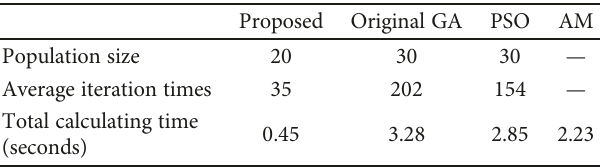
Figure 3: Comparison of calculating time using the proposed algorithm, original GA, PSO, and AM for WSF estimation. (a) p = 8 , q = 2 , and M = 100 ; all the signals are independent (noncoherent case). (b) p = 8 , q = 4 , and M = 100 ; the independent signal number is 2 (coherent case). Table 1: Comparison of computational complexity of each algorithm in